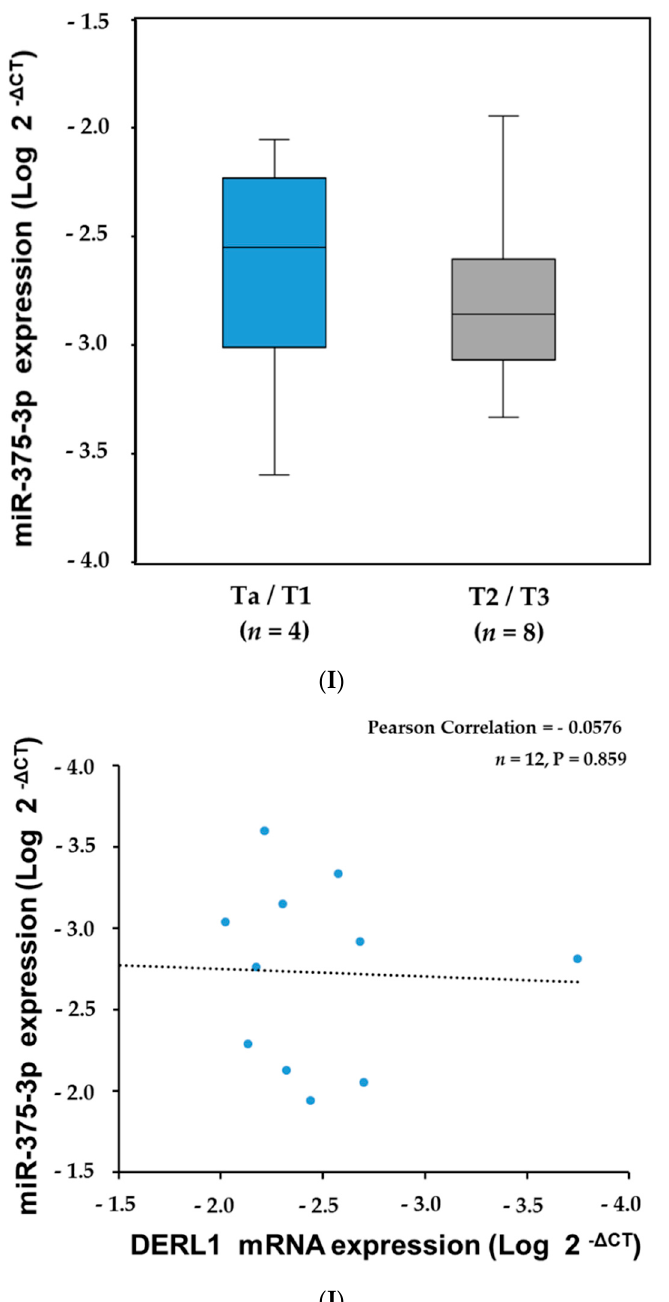
Figure 3. MiR-375-3p downregulates Derlin-1 protein expression via directly targeting Derlin-1 in UTUC cells. ( A ) miR-375-3p was identified as one of the potential candidate miRNAs from TargetScan 7.2 software. ( B ) BFTC909, UM-UC-14, and SV-HUC-1 cells were analyzed miR-375-3p expression by qRT-PCR (N = 3). ( C ) BFTC909 cells were analyzed miR-375-3p expression by qRT-PCR after transfected with scramble control or miR-375-3p mimics (N = 3). ( D ) Upregulation of miR-375-3p did not change the transcription of DERL1 in BFTC909 cells (N = 3). ( E ) miR-375-3p overexpression reduced Derlin-1 protein levels in BFTC909 cells (N = 3). ( F ) The possible binding site of hsa-miR-375-3p and Derlin-1 predicted by TargetScan. ( G ) Dual-luciferase reporter assay demonstrated miR-375-3p directly binding to Derlin-1 in BFTC909 cells. (N = 3). ( H – J ) The expression of Derlin-1 mRNA and miR-375-3p in our tumor specimens were examined. Data were represented as mean ± SD; * p < 0.05, ** p < 0.01. N.S: not significant.